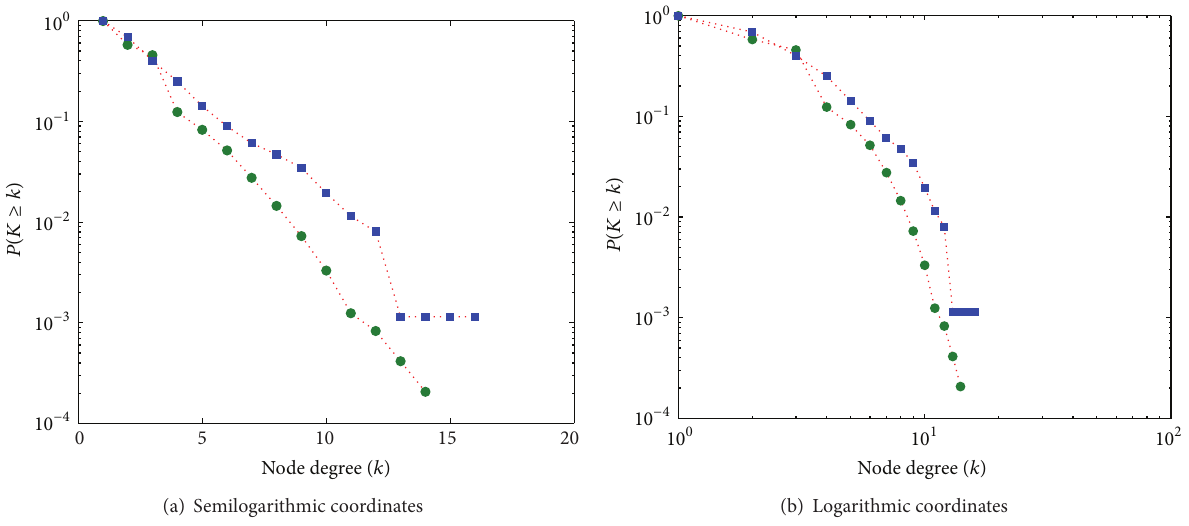
Figure 2: Cumulative degree distribution curves of NC Grid model 𝐺